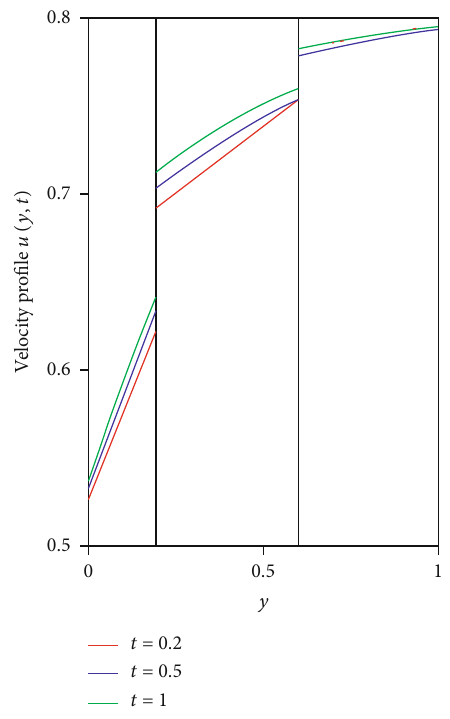
Figure 9: Velocity pro fi les u multilayer Maxwell fl uid at α λ = 0 : 042, λ = 0 : 06, and di ff erent values of time t . 2 3